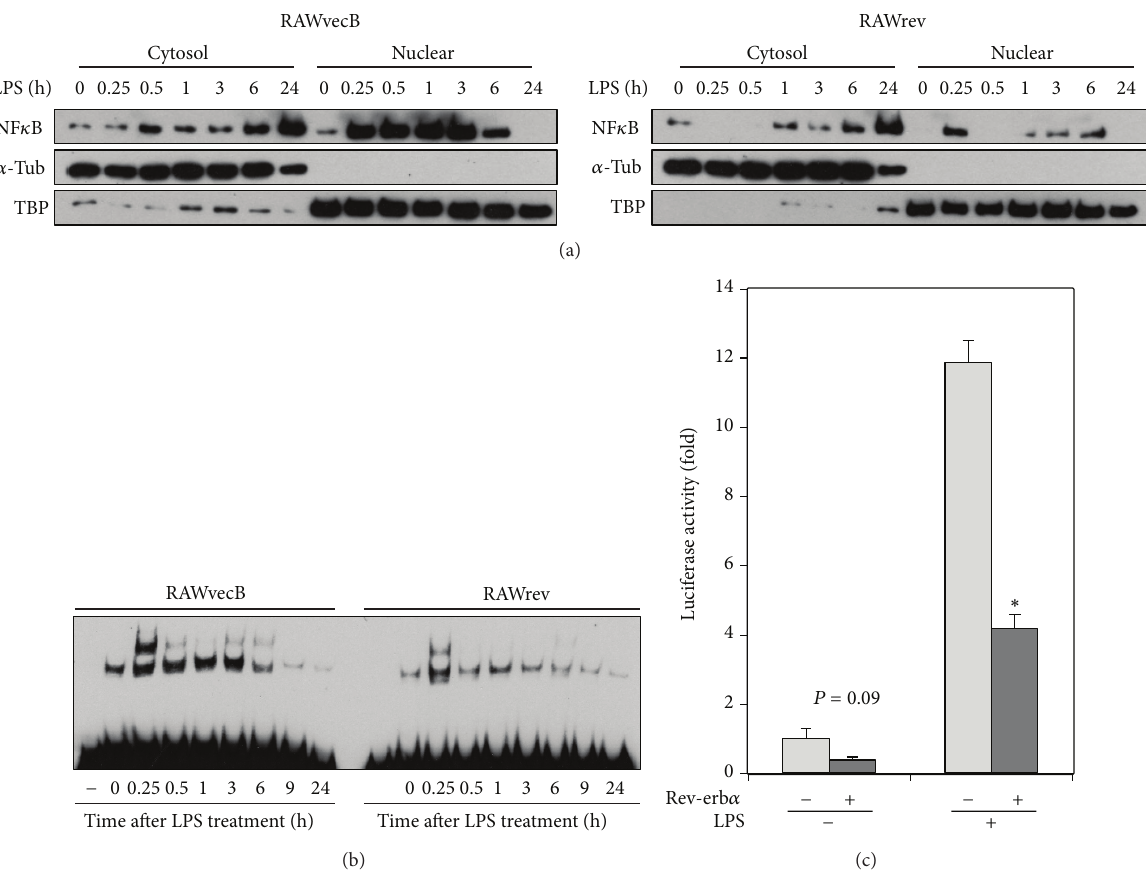
Figure 2: REV-ERB 𝛼 represses NF 𝜅 B activation in macrophages. (a) Nuclear and cytoplasmic fractions of each cell untreated or treated with LPS for various durations were analyzed by Western blot for p65 NF 𝜅 B, 𝛼 -Tub, and TBP. Detection of 𝛼 -Tub and TBP is used as marker of nuclear and cytoplasmic fractions, respectively. (b) Each cell was stimulated with LPS for varying durations and NF 𝜅 B activation was analyzed by EMSA. Data shown are representative of three separate experiments. (c) Each cell was transiently transfected with NF 𝜅 B-responsive promoter reporter luciferase construct and luciferase activities in each cell stimulated either with or without LPS for 24 h were analyzed. The data are presented as the means ± S.E. from sextuplicate cultures. ∗ 𝑃 < 0.01 versus vector